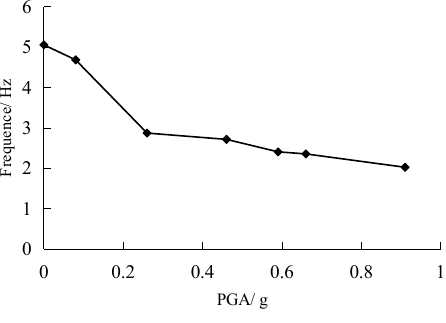
Figure 8. Decrease of the frequency.